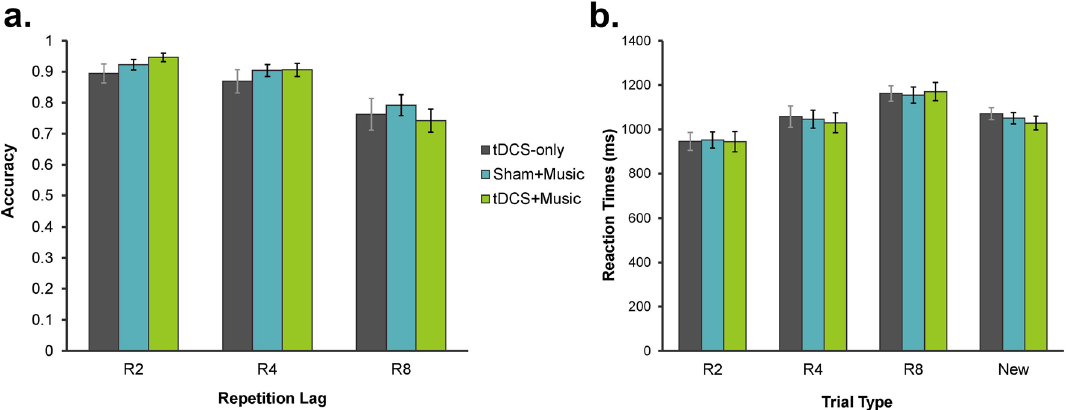
Figure 3. Performance on the auditory word recognition task across trial types in terms of ( a ) accuracy and ( b ) reaction times. Error bars represent standard